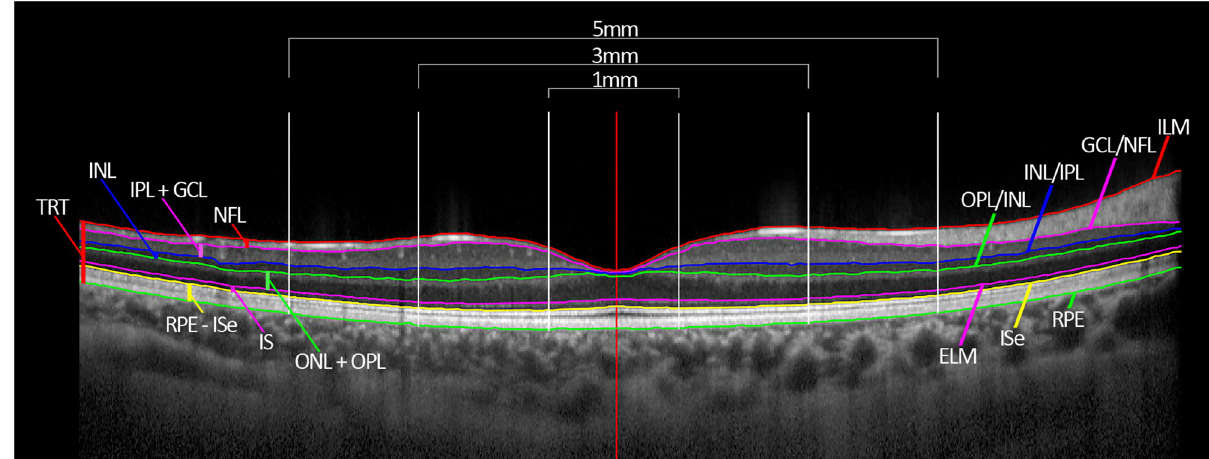
Fig 1. Example of the segmentation applied to each macula OCT image including the retinal layer boundaries: The internal limiting membrane (ILM), the ganglion cell layer (GCL)/nerve fibre layer (NFL) boundary, the inner nuclear layer (INL)/inner plexiform layer (IPL) boundary, the outer plexiform (OPL)/inner nuclear layer (INL) boundary, the external limiting membrane (ELM), the inner boundary of the inner segment ellipsoid band (ISe), and the outer boundary of the retinal pigment epithelium (RPE). Also shown are the total retinal thickness (TRT) measurement, and the individual layer thickness measurements including the inner retinal layers (the NFL, the IPL + GCL, and the INL), and the outer retinal layers (the outer nuclear layer (ONL) + OPL, the inner segment (IS), and the RPE to ISe layer).